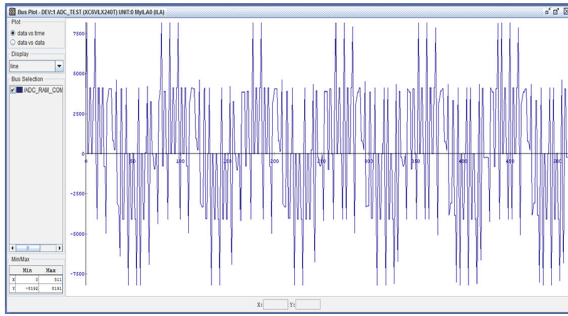
Figure 4: Bus Plot of ADC for the FPGA device